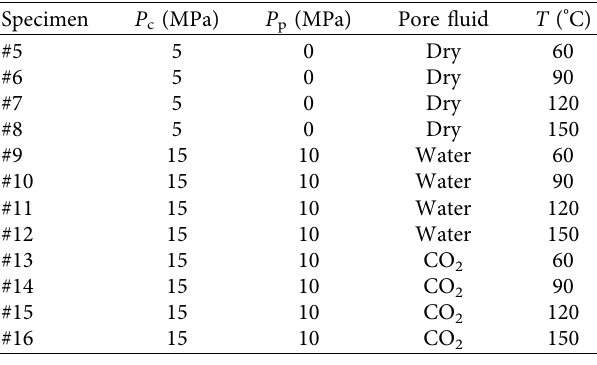
Table 2: Testing conditions for the triaxial compression experi- ments considering the effect of pore fluid and temperature.